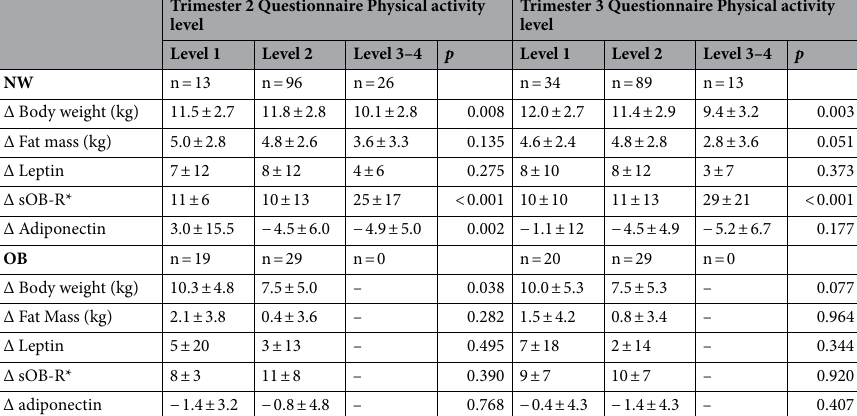
Table 3. Gestational changes in metabolic measurements dependent on self-reported activity levels. Significance determined with ANCOVA adjusted for age, BMI in trimester 1, parity and education. Δ denotes the gestational change from trimester 1 to trimester 3. *sOB-R analysis were made on a subset of women in, n = 84 for NW (n = 5, 59, 20 for activity levels in trimester 2 and n = 14, 57, 13 in trimester 3) and n = 33 for OB (n = 12, 21 for activity levels in trimester 2 and n = 13, 20 in trimester 3). Physical activity levels were reported according to the Saltin-Grimby physical activity level scale (in short: level 1 = sedentary, 2 = some physical activity, 3 = regular physical activity and exercise, 4 = regular hard physical training). NW, women of normal weight; OB, women with obesity.